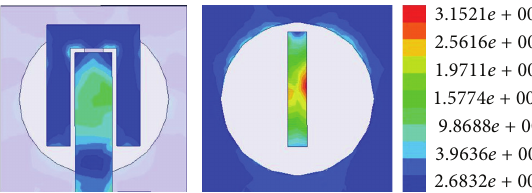
Figure 10: Current distribution pattern of the